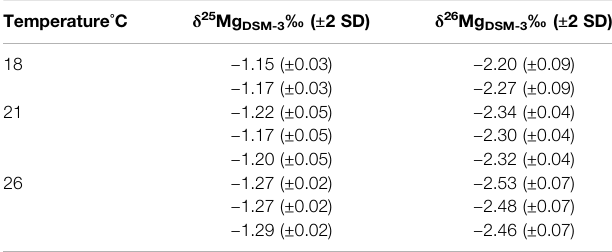
TABLE 3 | Mean δ 25 Mg and δ 26 Mg values ( ± 2 standard deviations; SD) relative to DSM-3 measured in Amphistegina lessonii cultured at different temperatures. Temperature ° C